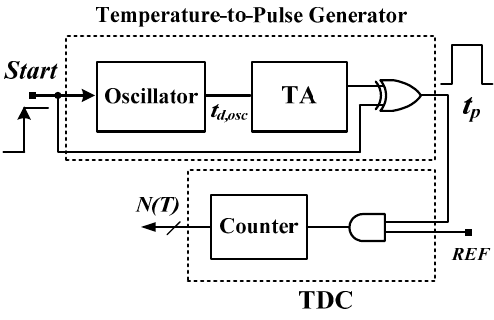
Figure 2. Architecture of oscillator-based smart temperature sensor.